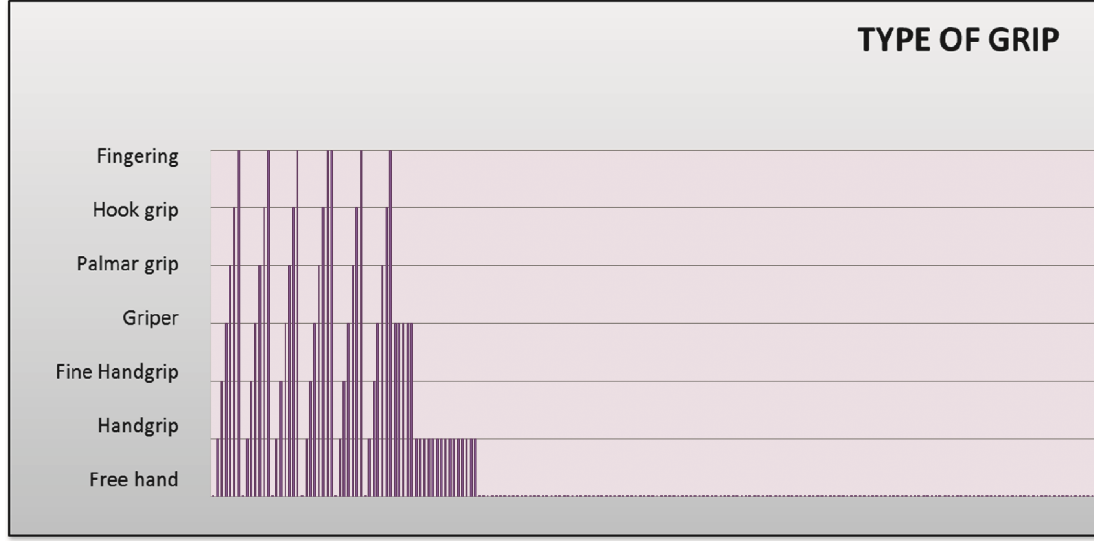
Figure 11. Graph of the types of grip.